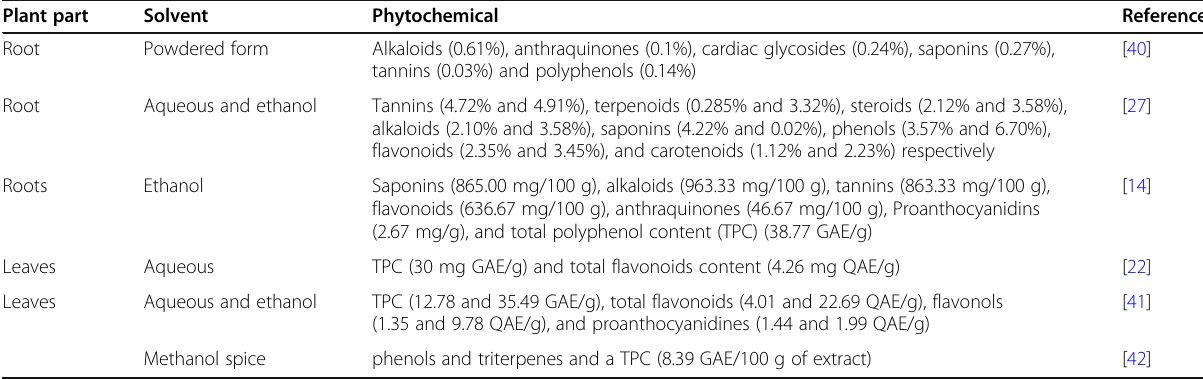
Table 2 Quantitative phytochemical contents of Olax subscorpioidea Plant part